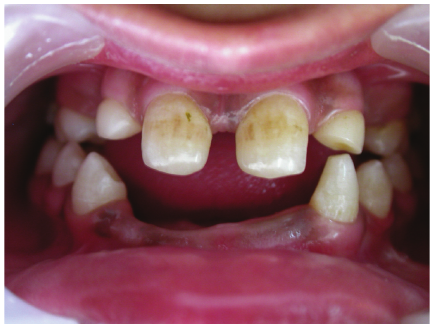
Figure 1: Missing lower anterior teeth.